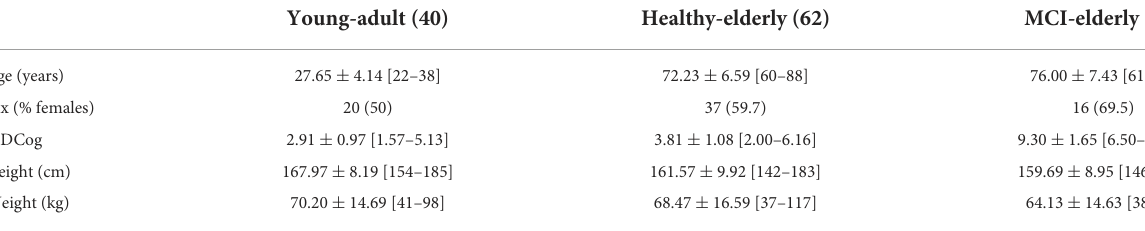
TABLE 1 Demographic characterization of the groups obtained by k-means clustering based on